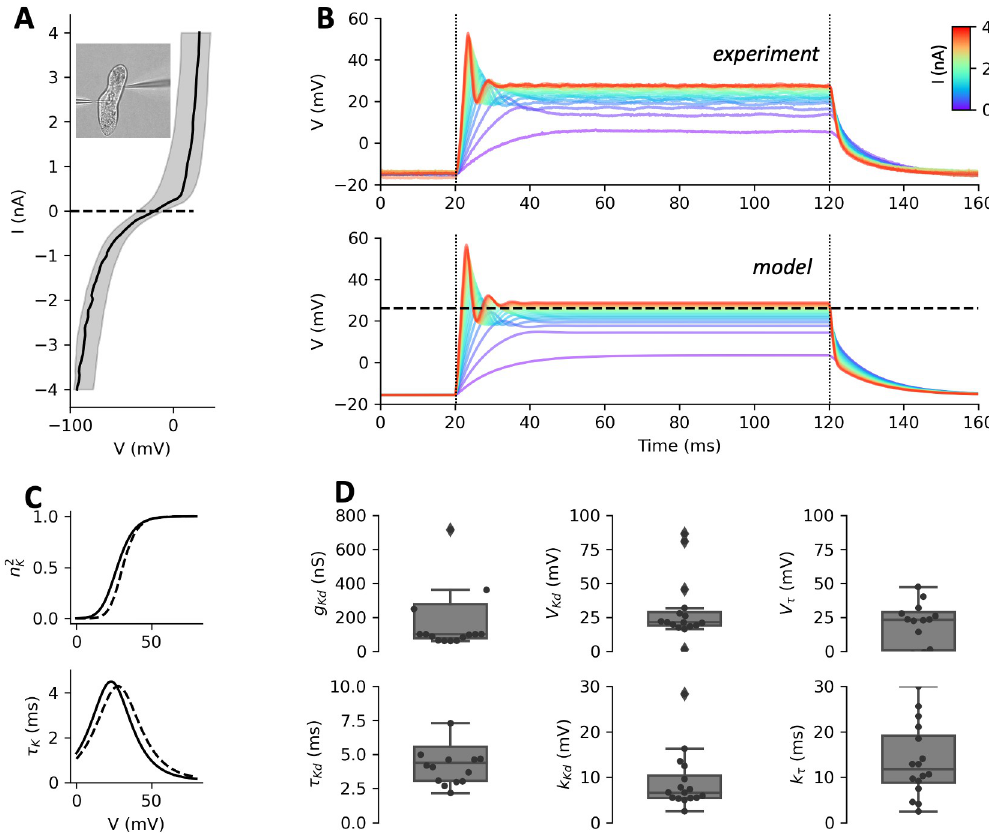
Fig 6. The delayed rectifier current measured in deciliated cells. A, Current-voltage relationship in deciliated cells, showing a strong delayed rectifier current for depolarized voltages, and the inward rectifier current for hyperpolarized voltages. B, Top: voltage responses of one cell to positive current pulses (I = 0 to 4 nA in 300 pA increments). Bottom: responses of the two-gate Boltzmann model fitted to the data, showing the inferred half-activation voltage of the delayed rectifier current (dashed). C, Activation and time constant of the delayed rectifier current as a function of voltage in fitted models, with median parameters (solid) and for the cell shown in B (dashed). D, Statistics of fitted parameters (n =